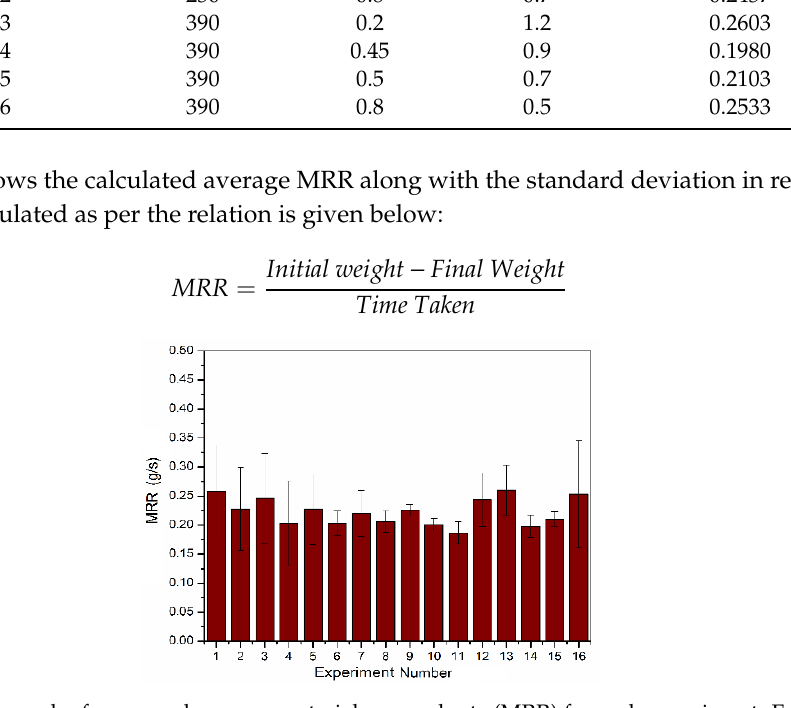
Table 2. Experimental results [1].